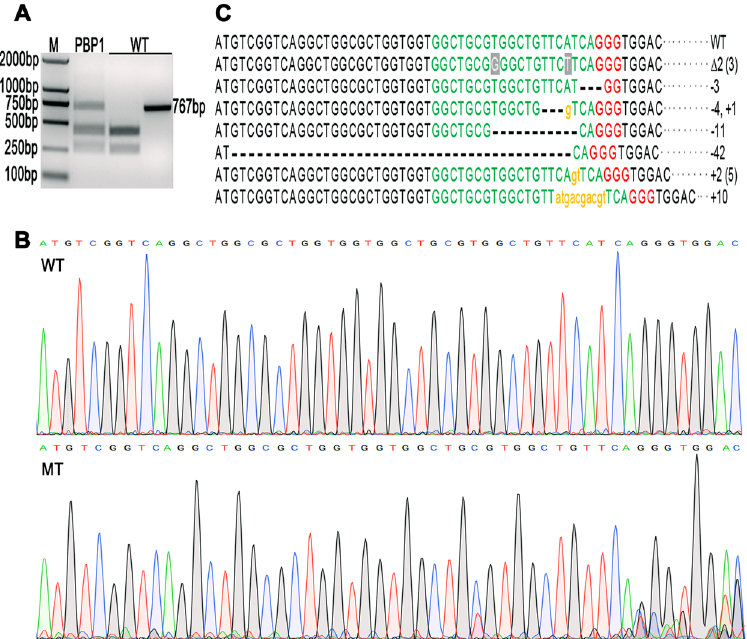
Figure 1. Targeted mutations of HarmPBP1 in eggs after injection of Cas9/sgRNA. ( A ) The mutation detection of pooled eggs, determined by the RED assay. M, marker; PBP1, enzyme digested PCR product (767 bp) of HarmPBP1 gene from the genomic DNA of 20 injected eggs; WT, controls of un-injected eggs, with the left being enzyme digested PCR products, and the right being un-digested products. ( B ) Chromatogram of direct sequencing of PCR product from the pooled G0 eggs. The top sequence is the WT sequence, and the bottom chromatogram shows multiple peaks, indicating the occurrence of mutations. ( C ) Sequences of indel mutations flanking the target site by TA clone sequencing from the uncleaved band of lane PBP1 in ( A ). The WT sequence is shown at the top with the target site in green and the PAM sequence in red. In mutant sequences, deleted bases are represented by dashes and inserted bases are shown as orange lower case letters, and substitutions are highlighted in grey shadow. The numbers of bases deleted or inserted are marked at the right side of sequences ( + , insertion; − , deletion). Total of 15 positive clones were succesfully sequenced, and the number of clones with same indel mutations is shown in